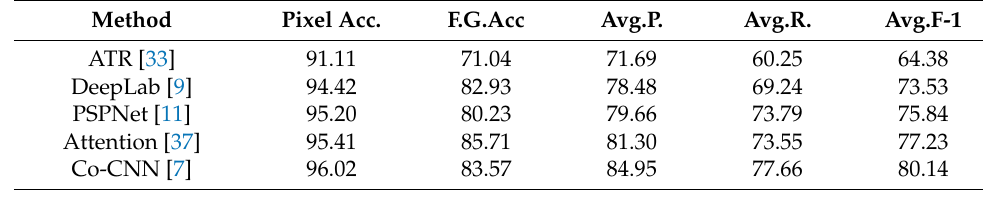
Table 4. Comparison of different methods on the ATR test dataset.